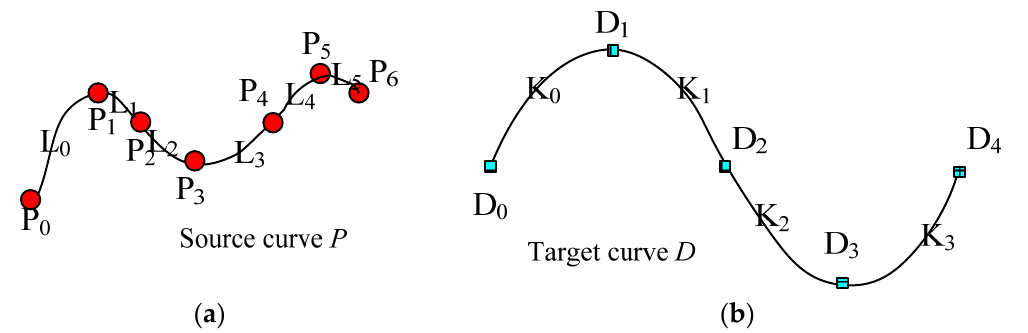
Figure 5. ( a ) Key points on the central curve P of source yarn. ( b ). Key points on the target curve D.